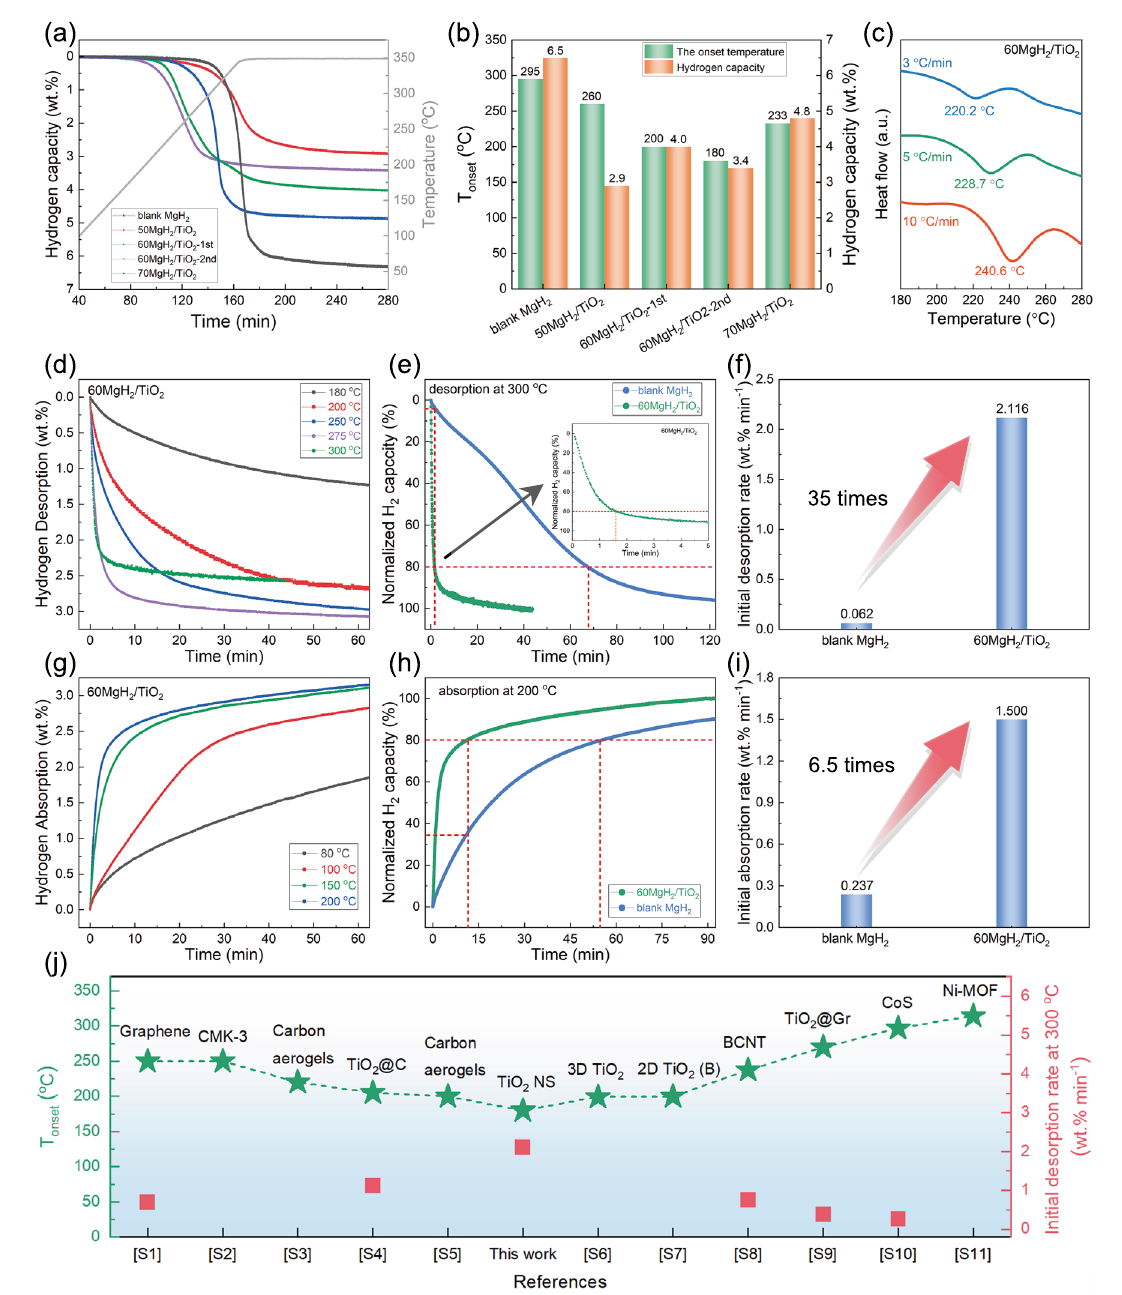
Fig. 2 a, b TPD curves and corresponding onset desorption temperature and hydrogen capacity of blank MgH 2 , 50MgH 2 /TiO 2 , 60MgH 2 /TiO 2 - 1st, 60MgH 2 /TiO 2 -2nd, and 70MgH 2 /TiO 2 . c DSC curves of 60MgH 2 /TiO 2 . d Isothermal dehydrogenation profiles of 60MgH 2 /TiO 2 . e Isother- mal dehydrogenation curves and f initial desorption rate of 60MgH 2 /TiO 2 and blank MgH 2 at 300 °C. g Isothermal re-hydrogenation profiles of 60MgH 2 /TiO 2 . h Isothermal re-hydrogenation curves and i initial absorption rate of 60MgH 2 /TiO 2 and blank MgH 2 at 200 °C. j Comparison of the onset desorption temperature and initial desorption rates at 300 °C of MgH 2 /TiO 2 heterostructure with those of other nano-confined MgH 2 systems and TiO 2 catalyzed MgH 2 systems in the literature (Table